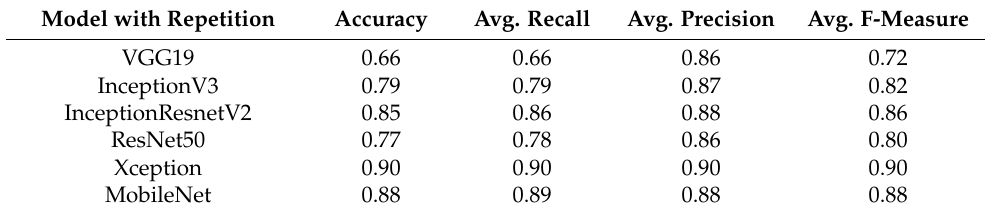
Table 3. Performance of transfer learning nets with repetition of images. Model with